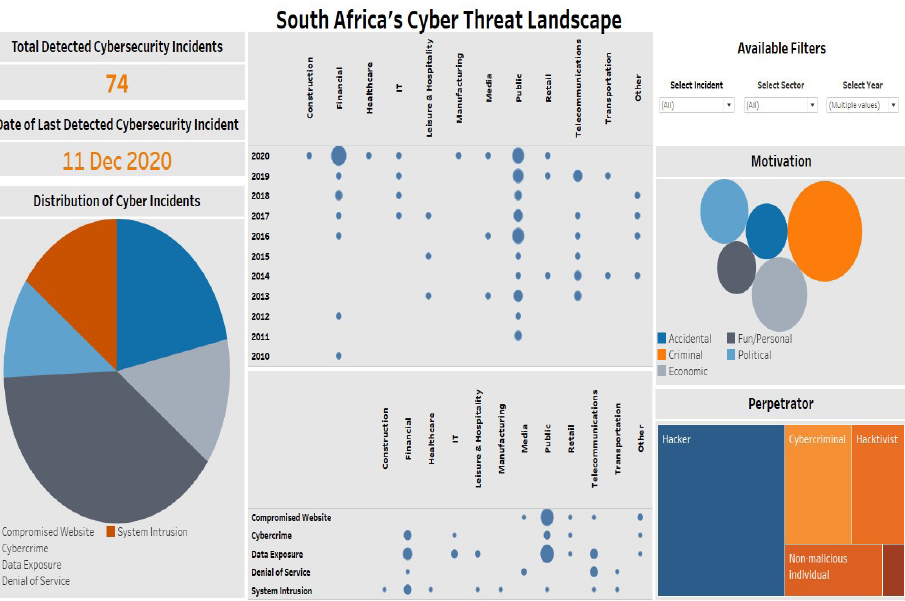
Figure 11: Dashboard visualisation of South Africa’s cyber threat